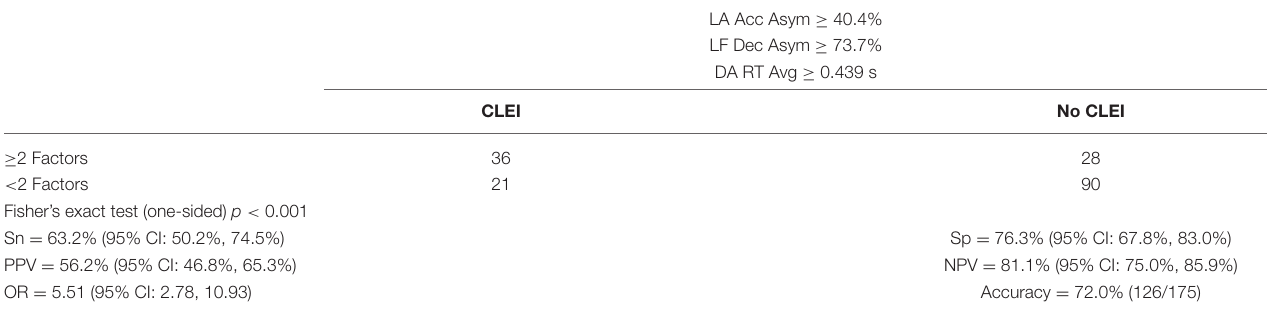
TABLE 6 | 2 × 2 cross-tabulation table for the 3-factor model, ≥ 2 factors.